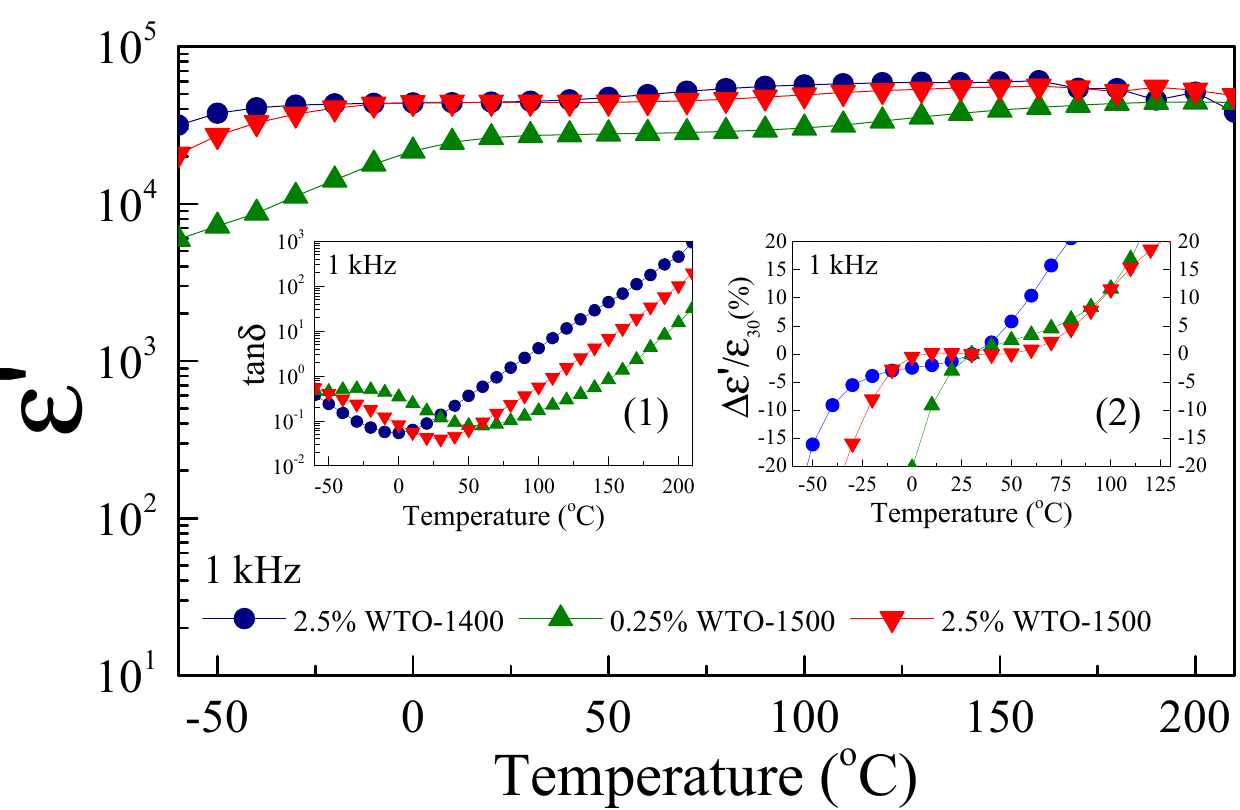
Figure 6. Temperature dependence of ε ′ at 1 kHz of WTO ceramics; insets (1) and (2) show tan δ and temperature coefficient values.